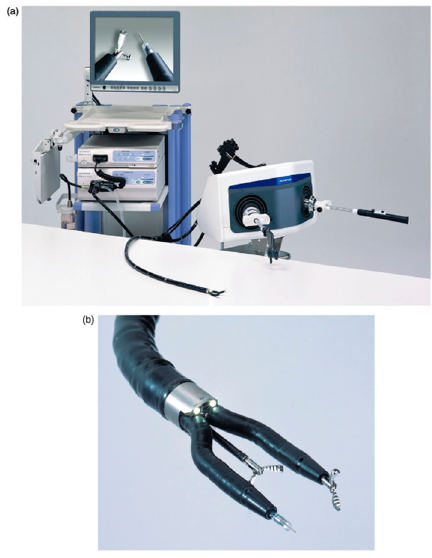
Figure 4. The ENDOSAMURAI by Olympus is a platform with two arms fitted to the tip of an endoscope that includes forceps channels in addition to the endoscope itself and its two arms. ( a ) The platform and ( b ) closeup of the tip of the instrument. Image taken from Kume, 2016 [28] .